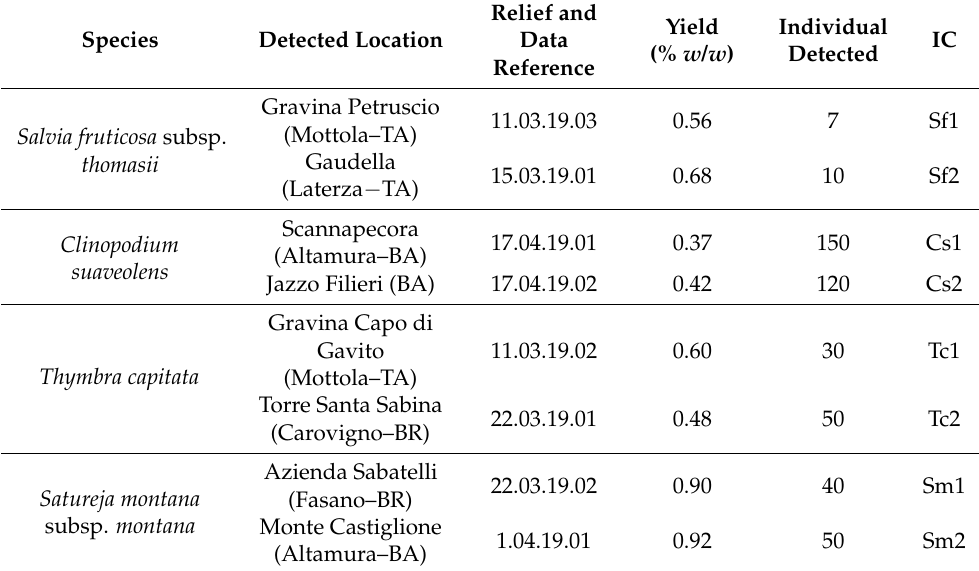
Relief and Yield Individual IC Data (% w / w ) Detected Reference